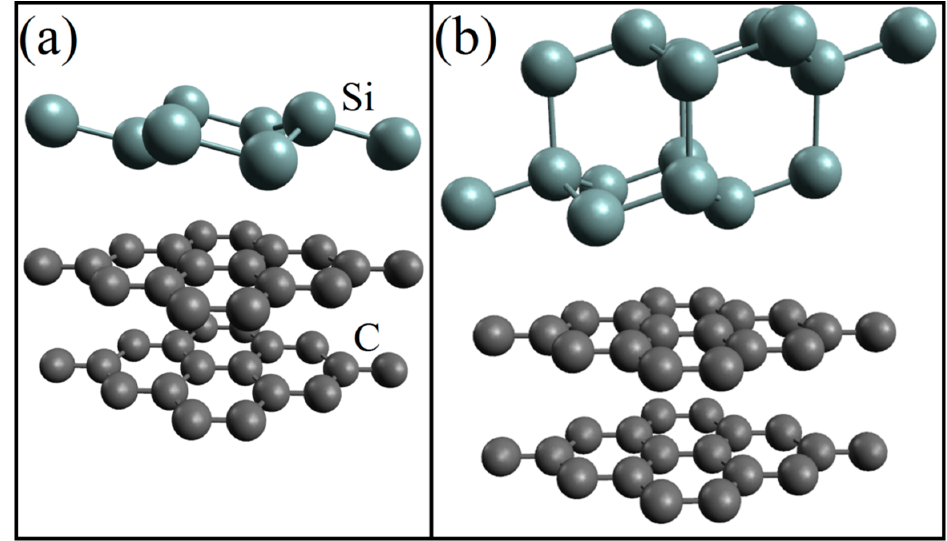
Figure 5. Geometric structure of ( a ) one- and ( b ) two-layer silicene on a graphite substrate after geometric optimization.